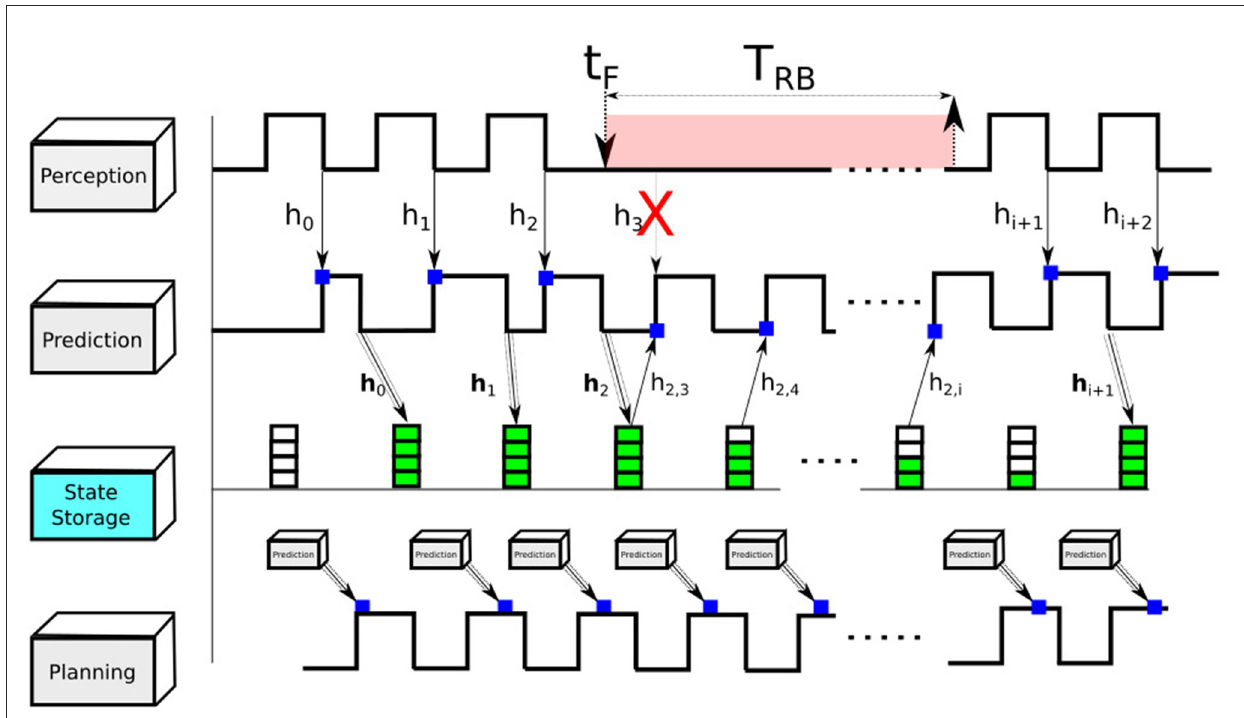
FIGURE4 Temporal logic schematic of Perception module